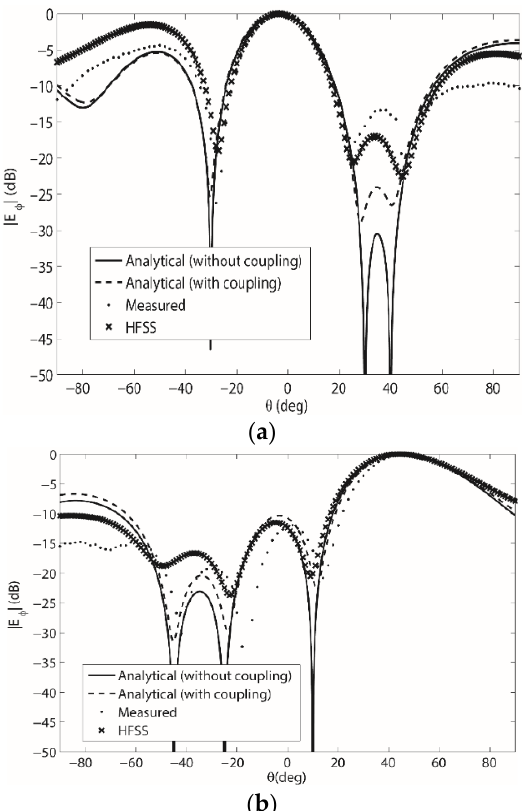
Figure 6. ( a ) Pattern 1 beamforming results for the 1 × 4 microstrip patch array on the singly curved (wedge-shaped) surface with θ b = 30 ◦ ; ( b ) Pattern 2 beamforming results for the 1 × 4 microstrip patch array on the singly curved (wedge-shaped) surface with θ b = 30 ◦